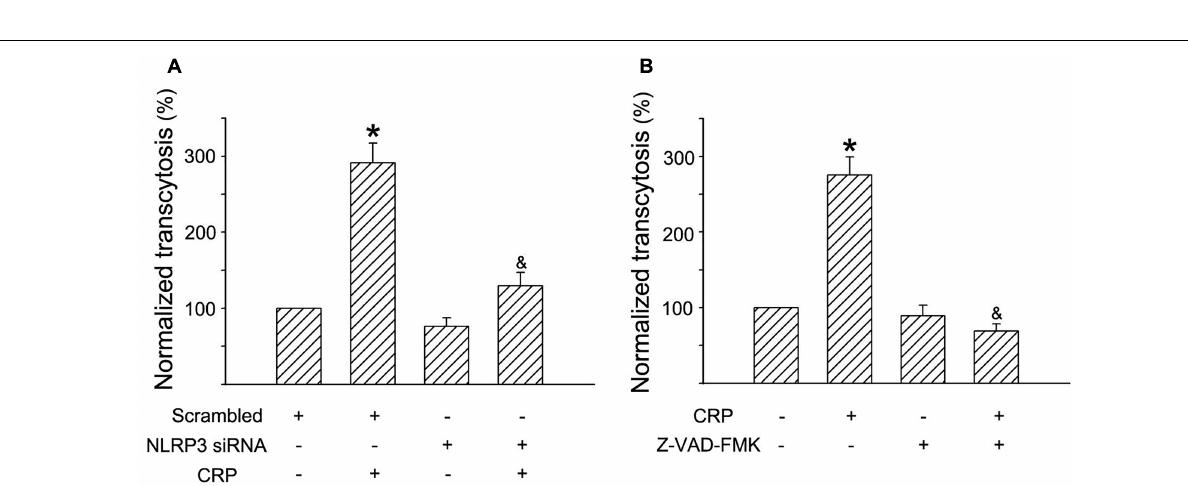
Frontiers in Pharmacology |